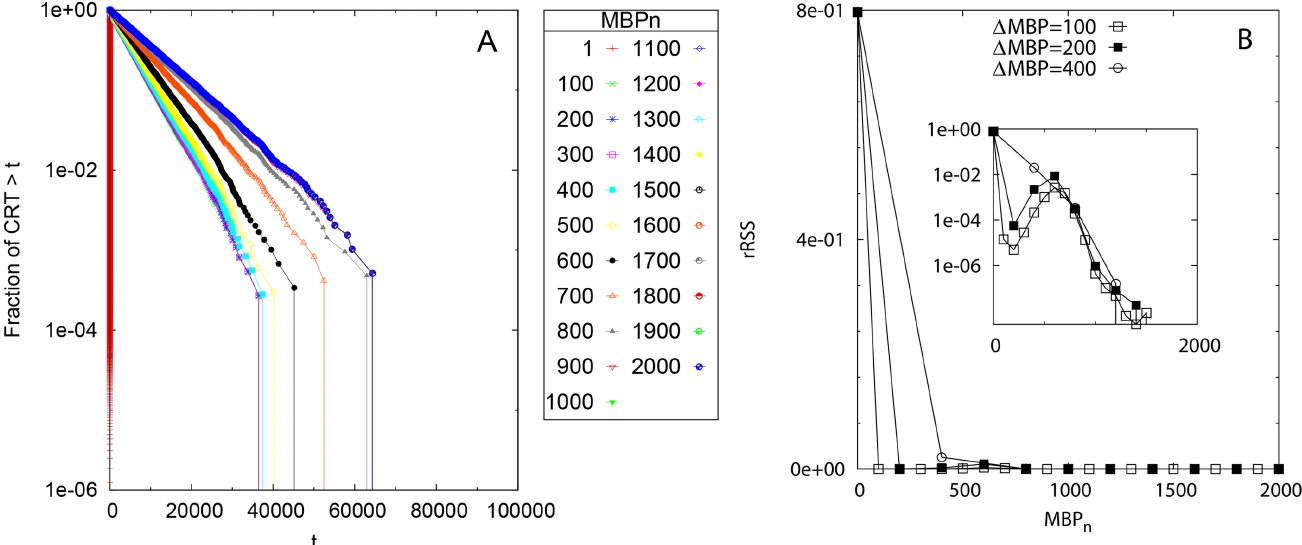
Fig 5. Scenario 3: Survival curves of CRT and renormalized sum of squared residuals. (A) Survival curves of CRT obtained for different values of MBP n (see legend). (B) rSSR in semi-logarithmic scale calculated among pairs of survival curves of residence times with variable Δ MBP (see legend). Inset: the same in semi-logarithmic scale.